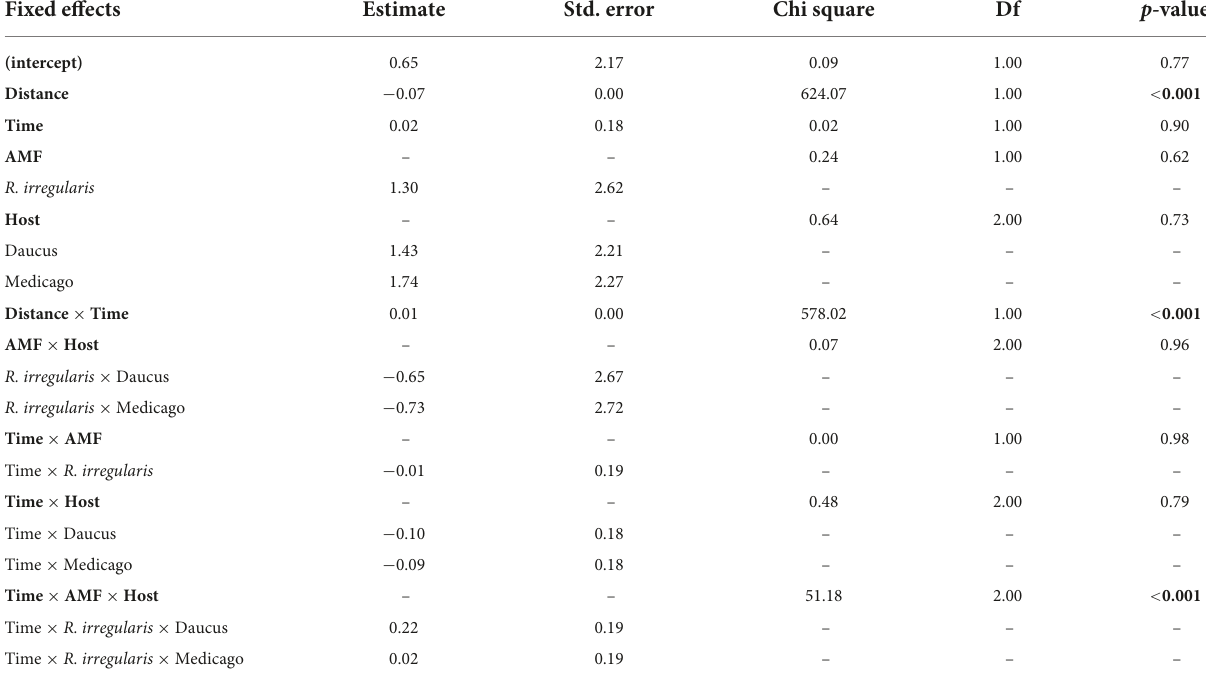
TABLE 2 The general linear mixed model (GLMM) comparing the sporulation at 8–12 wpi in the hyphal compartment (HC) of four pairs of host (Medicago and Daucus) and AMF ( R. irregularis and R. clarus ) as a function of a three-way interaction between host, AMF, and time